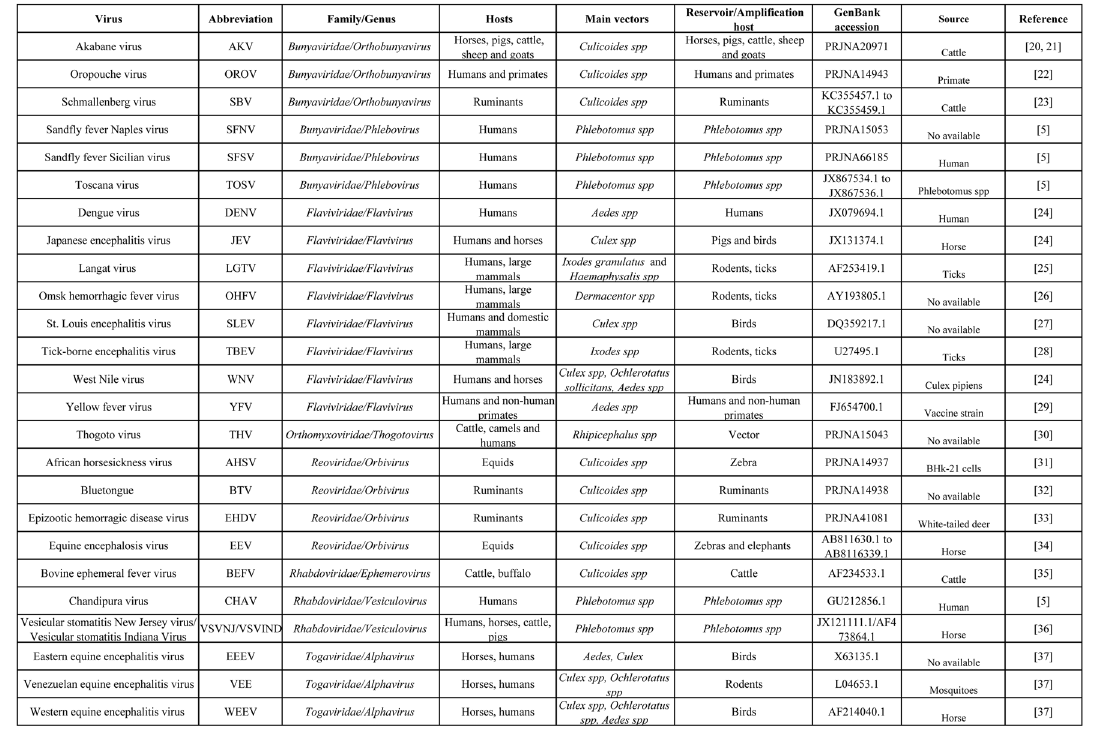
Fig 1. General information about viral species used in this study. Twenty-six different viruses comprised of 6 different viral families that represent the most common fully sequenced arboviruses were used for this study.